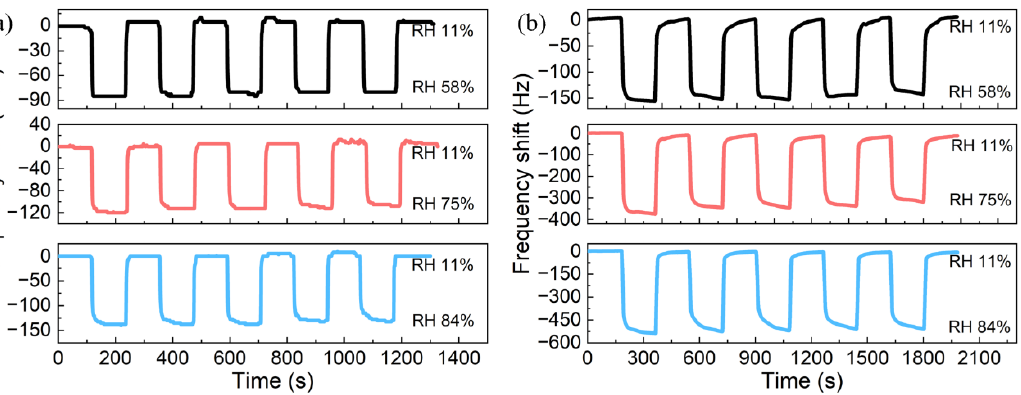
Figure 9. Repeatability of the sensors as the RH level switches from 11% to 58%, 75%, and 84%: ( a ) CMUT; ( b ) QCM. ( a ) CMUT; ( b )